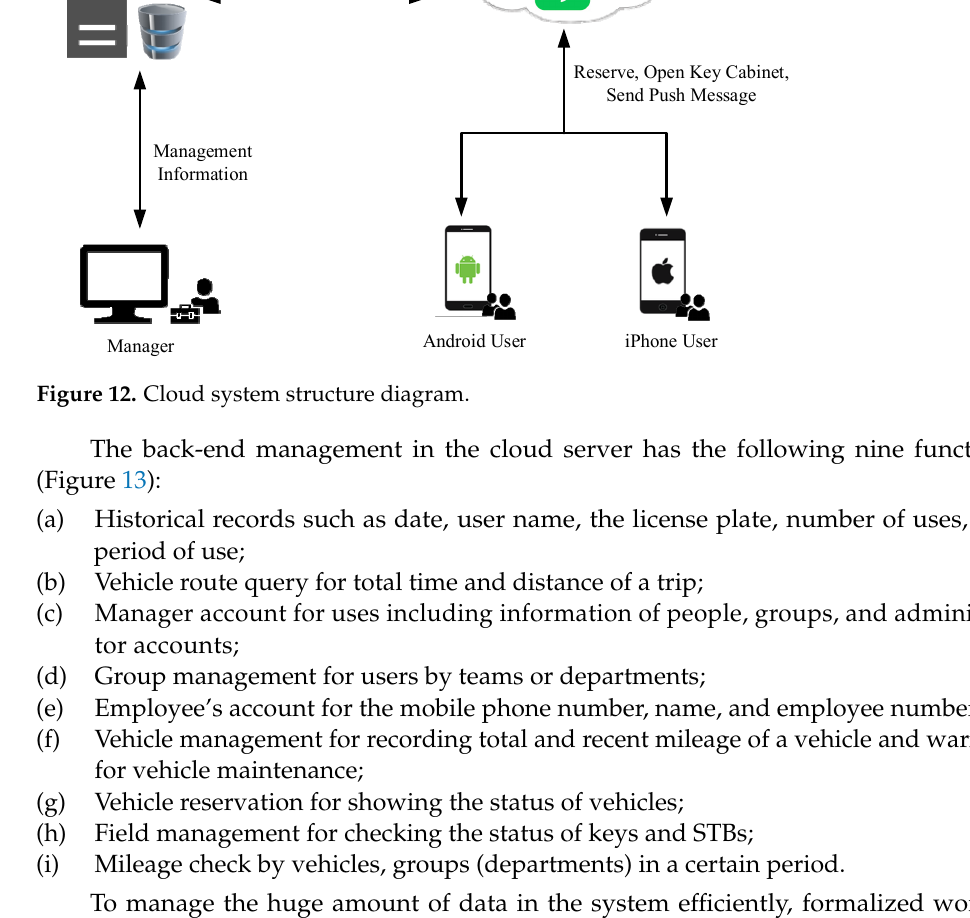
Figure 11. RFID memory configuration diagram.